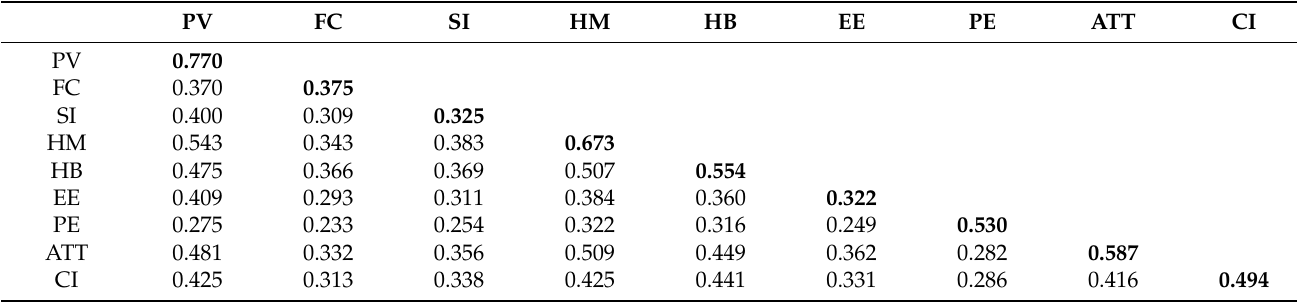
Table 4. The discriminant validity